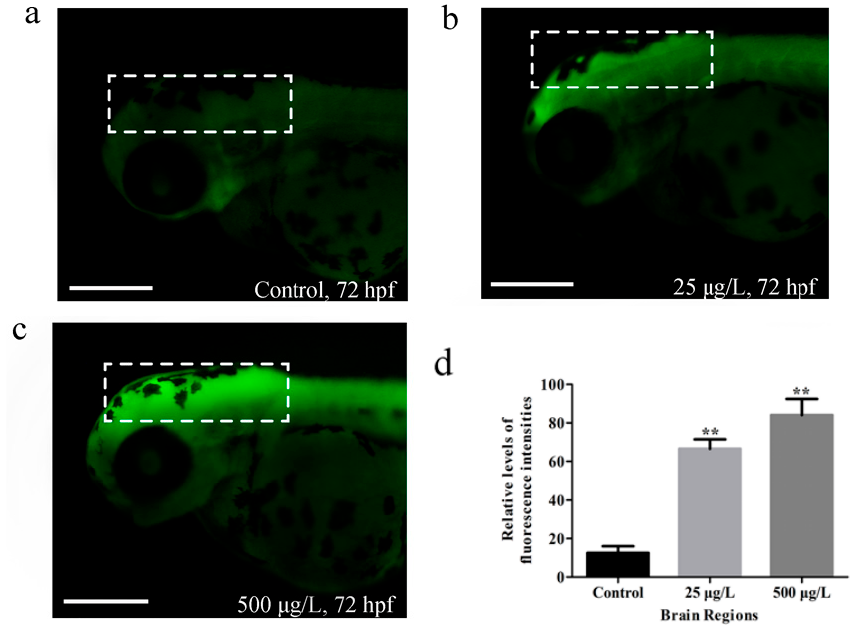
Figure 4. Apoptosis in the brain of zebrafish larvae induced by methamidophos exposure detected with AO staining at 72 hpf. Scale bars: 250 µ m ( a – c ). Relative levels of fluorescence intensity in the brain regions ( d ). ** p < 0.01.